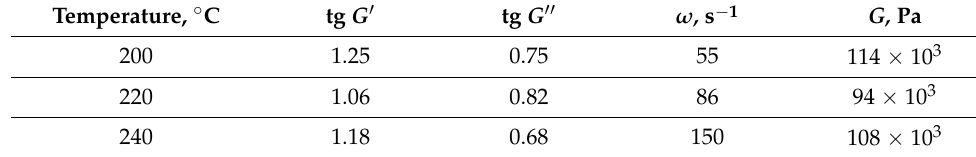
Table 1. Viscoelastic behavior of the 50Al 2 O 3 /50PLA composition.